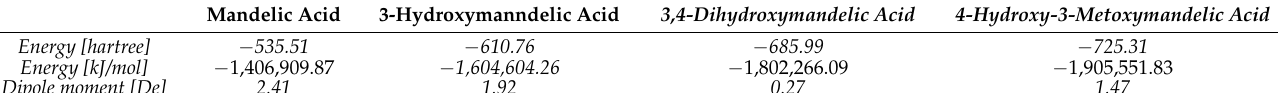
Table 1. Structural parameters of studied mandelic acid and its derivatives.